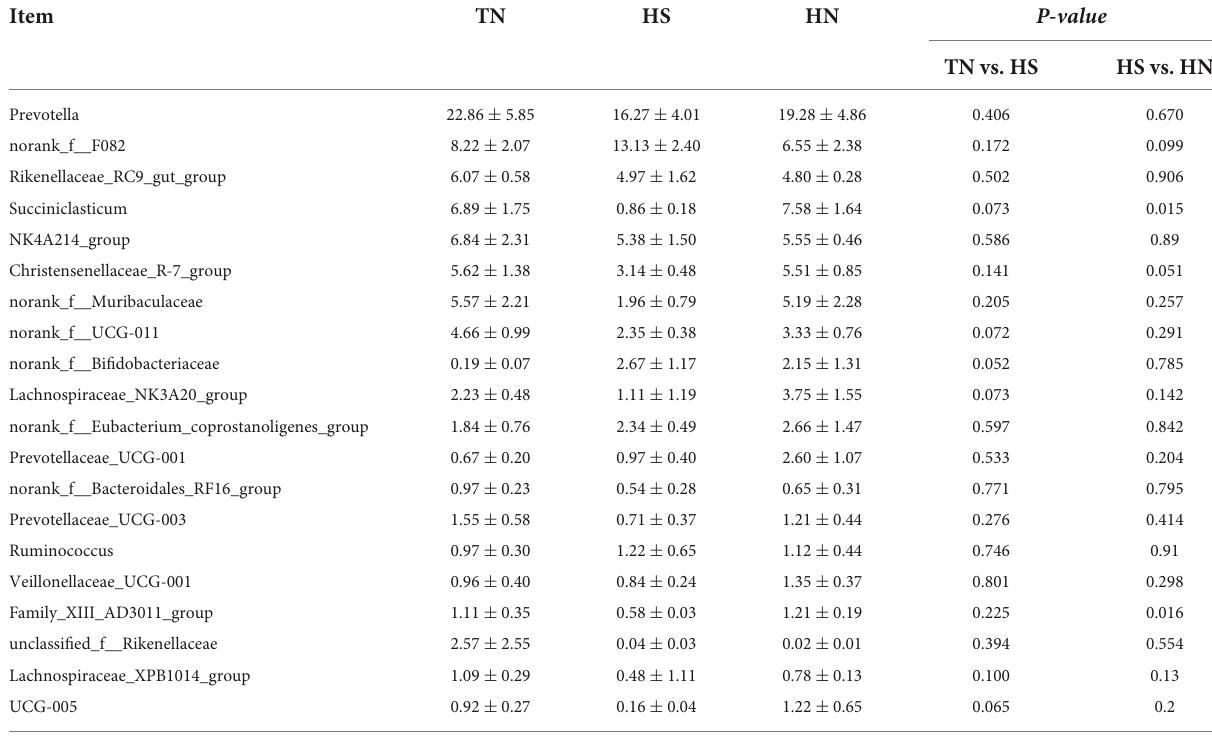
TABLE 9 Effects of niacin on rumen bacterial flora structure (genus